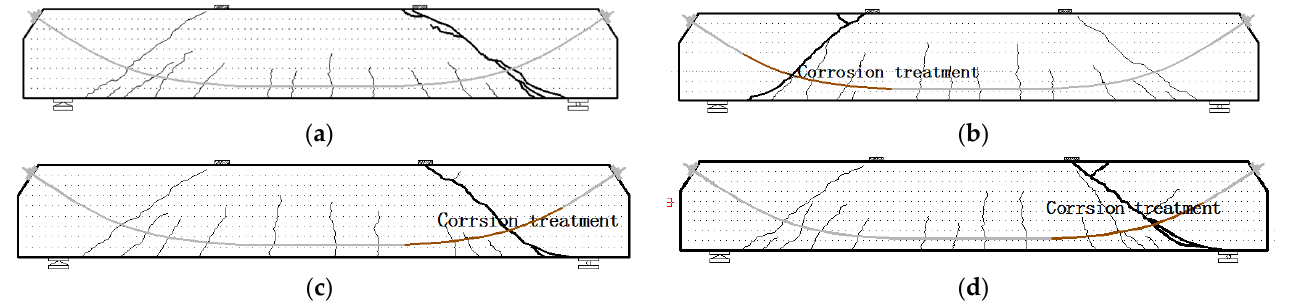
Figure 3. Crack distribution under the ultimate loading state. ( a ) B1 beam; ( b ) B2 beam; ( c ) B3 beam; ( d ) B4 beam.